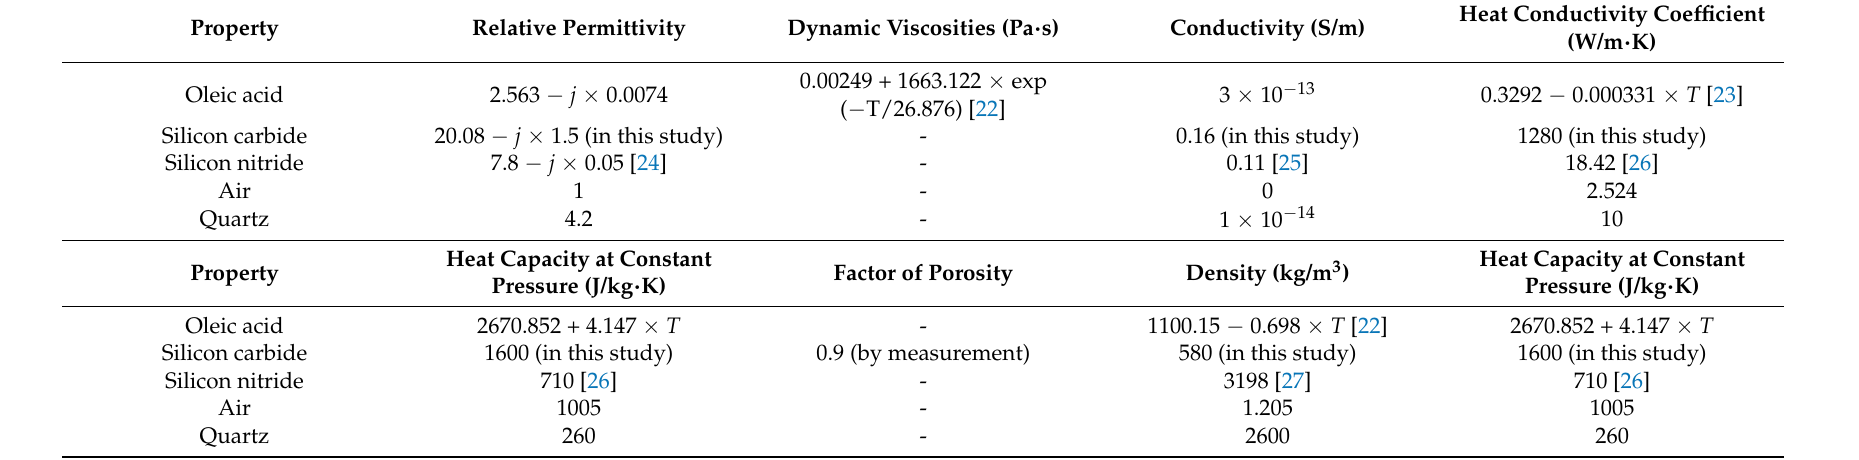
Table 1. Summary of material properties applied in the